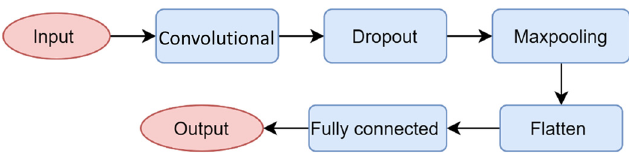
Figure 5: The CNN